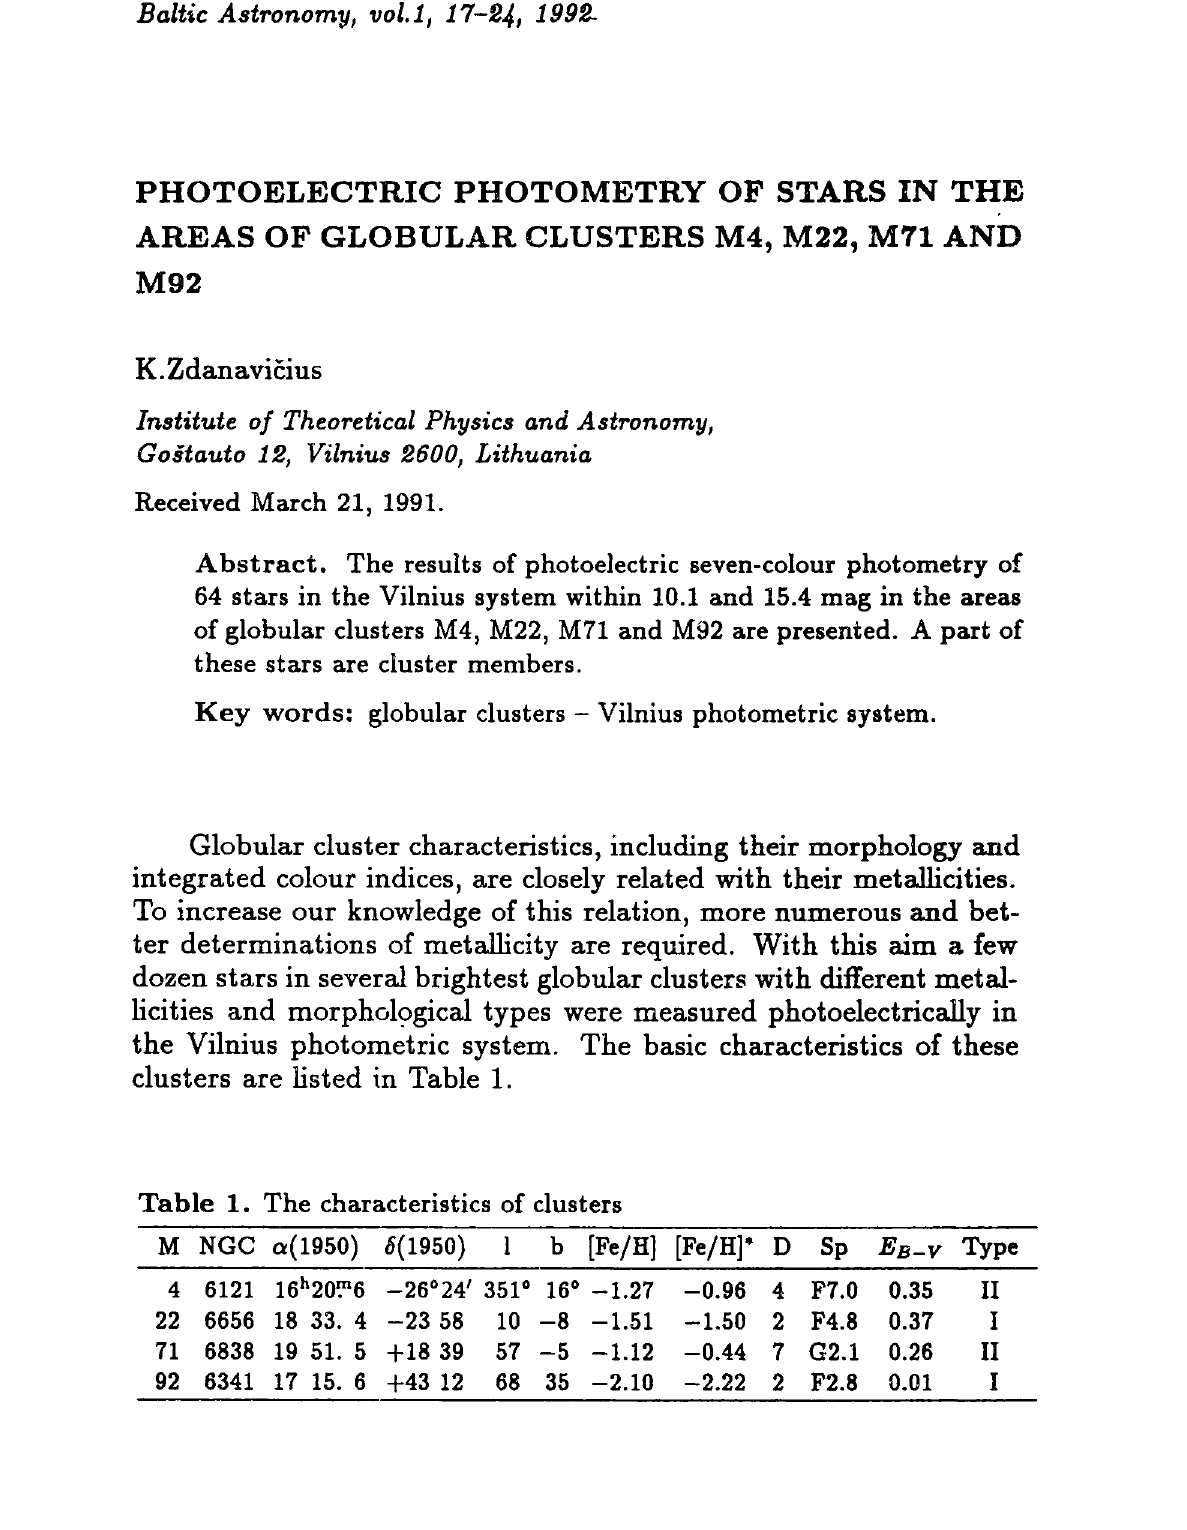
Table 1. The characteristics of